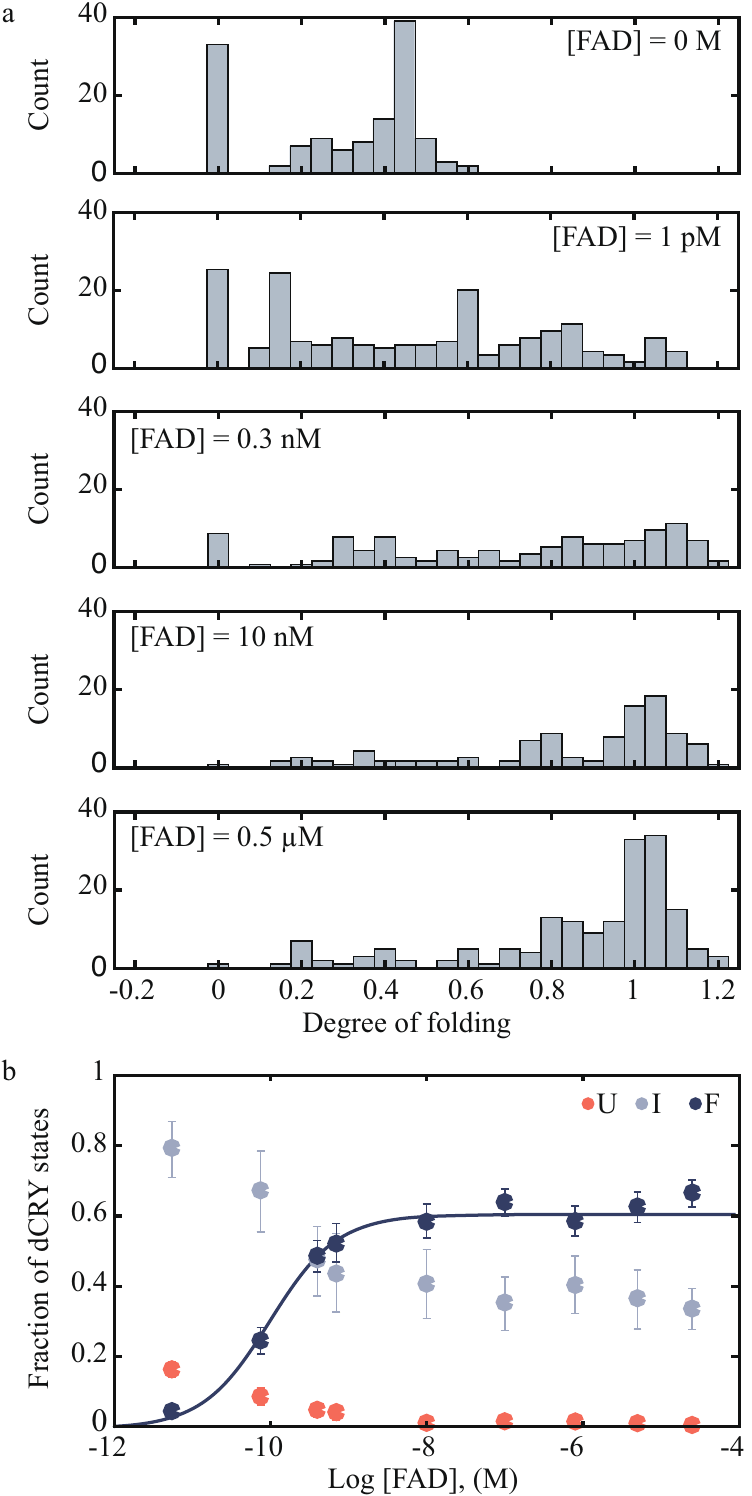
Fig. 2| Single-moleculeFAD titration.a Histogramsof populationof dCRYstates vs. degree of folding in the presence of varying FAD concentrations. Unfolded, intermediate and folded states are shaded in light red, light blue and gray. b Fraction of dCRY states (U unfolded, I intermediates, and F folded) plotted as a function of FAD concentration. The folded fraction, F, which is assumed to be bound to FAD, was fi tted to a single site binding isotherm to obtain an apparent